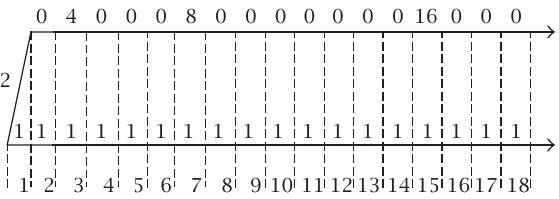
Figure 3.4. State-space diagram for Example